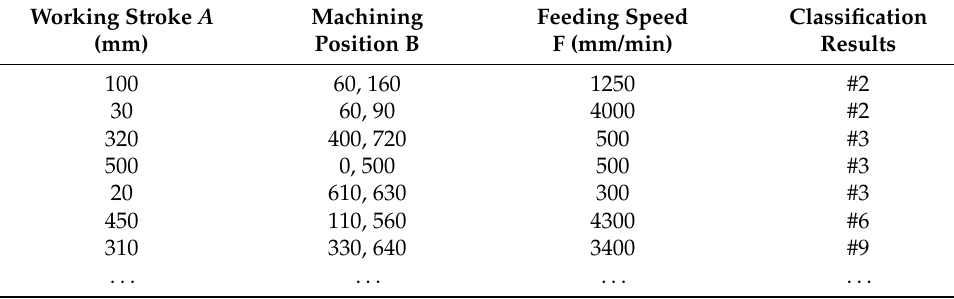
Table 6. Random simulation of classification of working